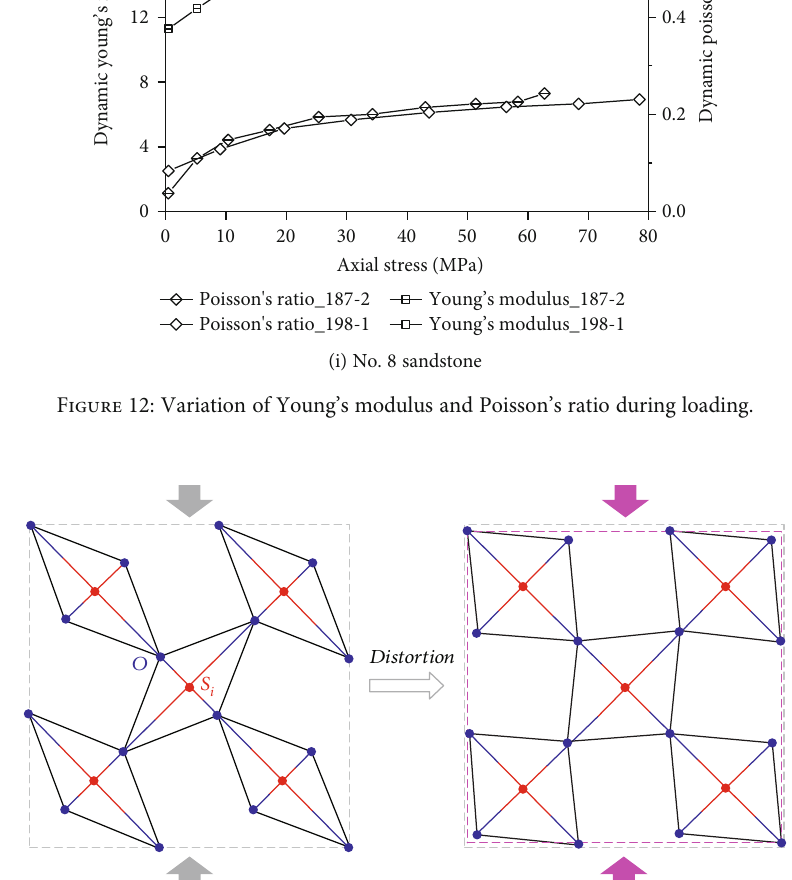
O and distortion mechanism of negative Poisson ’ s ratio (modi fi ed from [32]). i 2